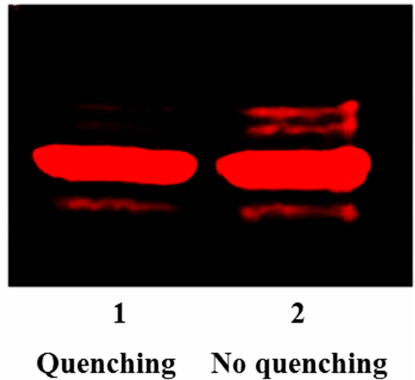
Figure 3. Fluorescence intensities of rhodamine-aldehyde labeled N -Hcy myoglobin with and without cysteamine quenching reaction. Lane 1: 7.8 μ M modified myoglobin including 3.1 μ M N -Hcy myoglobin and 4.7 μ M native myoglobin with cysteamine (500 μ M) quenching; Lane 2: 7.8 μ M modified myoglobin including 3.1 μ M N -Hcy myoglobin and 4.7 μ M native myoglobin without cysteamine quenching.